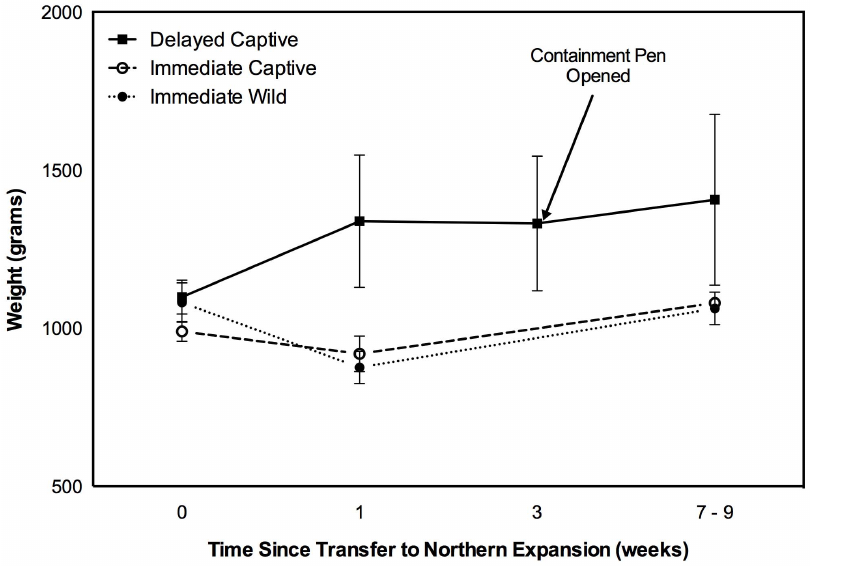
Figure 3. Average weights of delayed, immediate wild and immediate captive greater bilbies released into the Northern Paddock in 2003. Only three delayed and three immediate captive bilbies could be recaptured at seven to nine weeks for reweighing. Bars denote 1 standard error. Arrow indicates when release pen was opened.